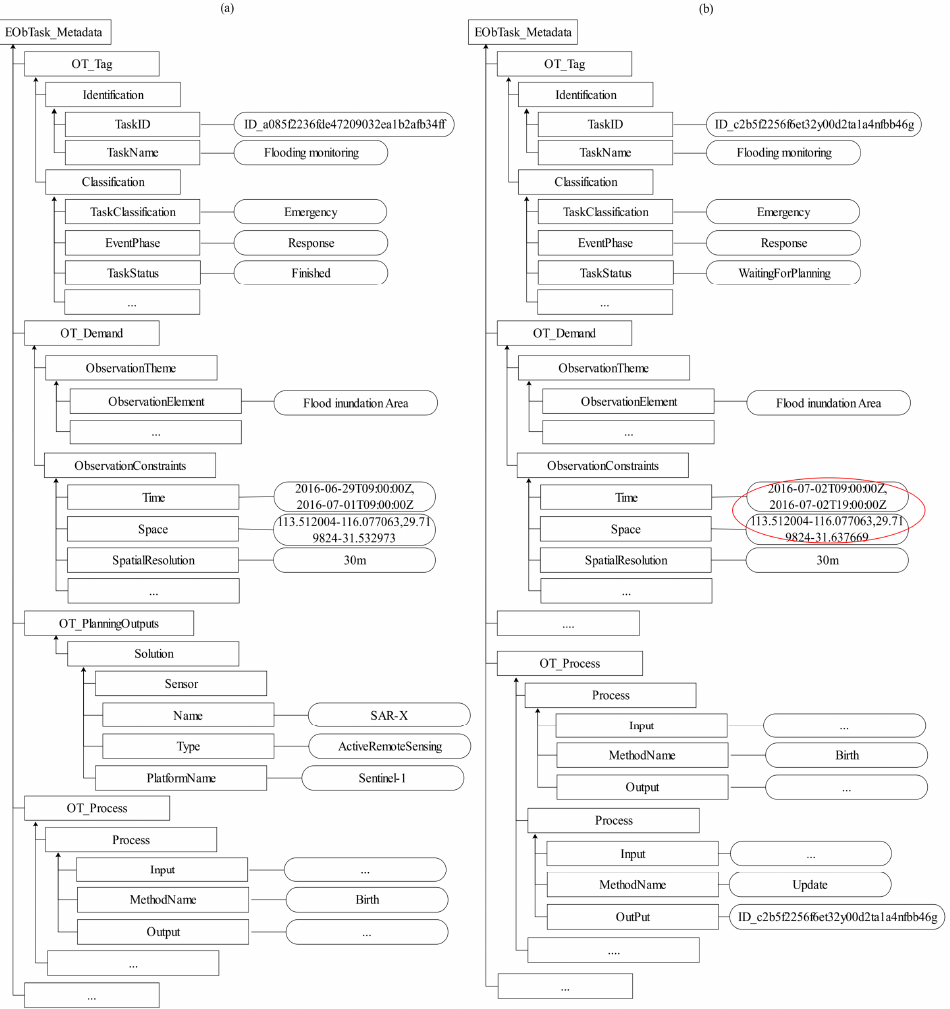
Figure 10. Segments of earth observation task representation instances (part). ( a ) Flood inundation observation task and ( b ) updated flood inundation observation task (the red circle shows the updated time and space information).